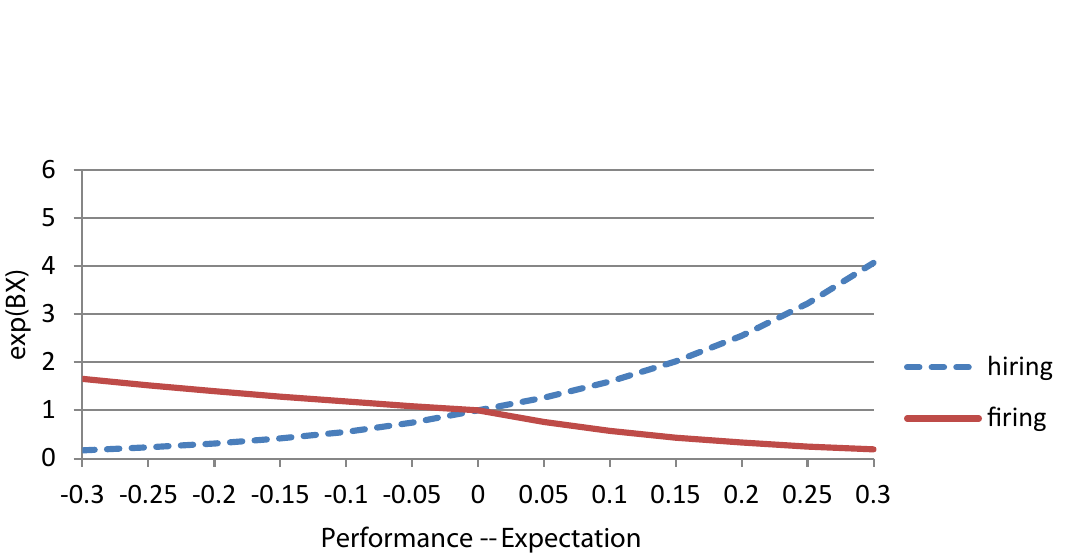
Figure 4: Estimated hazard multipliers for performance relative to social expectation (win/loss record of